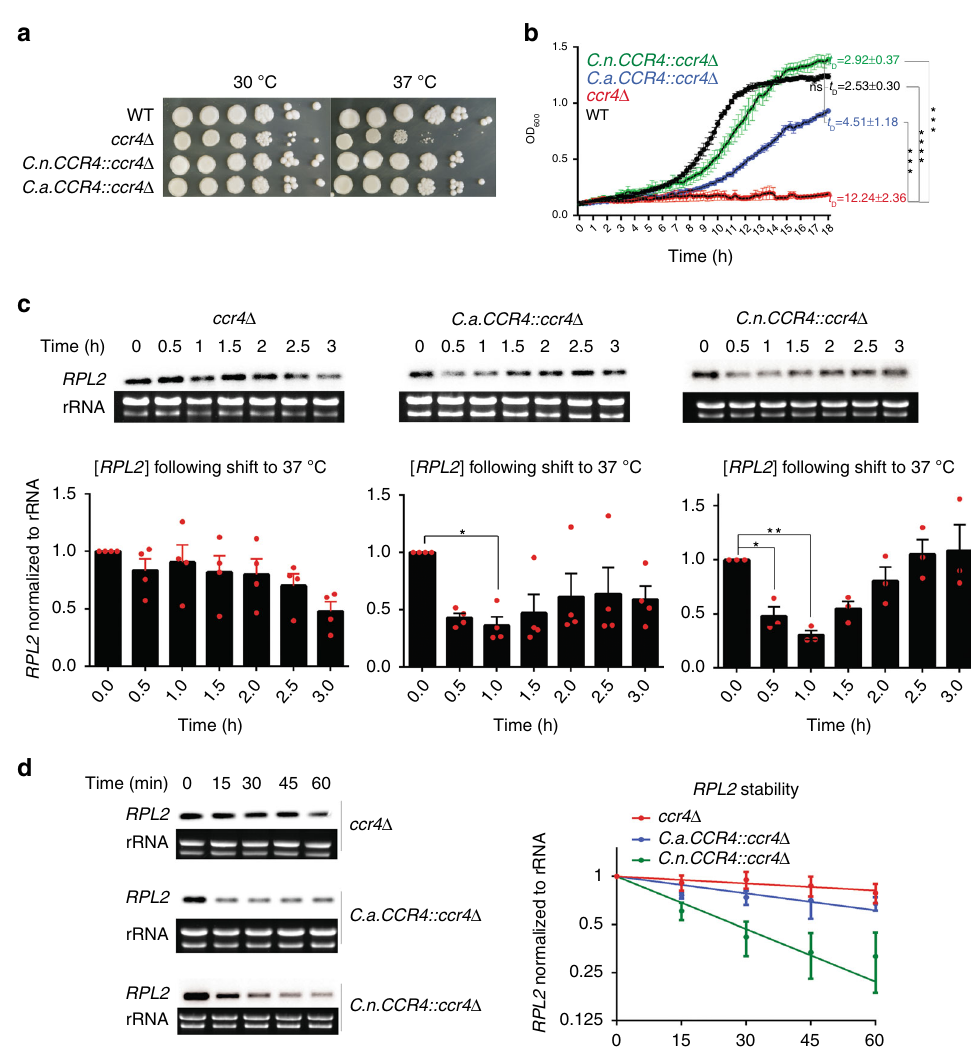
Fig. 2 C. amylolentus Ccr4 is functional and responds to 37 °C stress. a Cultures of wild-type C. neoformans , the C. neoformans ccr4 Δ mutant, the C. neoformans (C.n.) CCR4 :: ccr4 Δ , and the ccr4 Δ mutant strain expressing the C. amylolentus CCR4 ( C.a.CCR4::ccr4 Δ ) gene were adjusted to OD followed by tenfold serial dilution. In total, 5 µ l of each dilution was spotted onto YPD agar plates and incubated at either 30 °C or 37 °C for 3 days. Images are representative of three biological replicates. b Growth curve analysis. Strains were incubated at 37 °C with orbital shaking for 18 h. Plotted are OD 600 ± s.e.m. from 15 min increments; n = 3. Doubling times ( t D ) during exponential growth were compared by ANOVA and Tukey ’ s test post hoc, n = 3. c RPL2 expression following a shift to host temperature for 3 h was assessed by northern blot analyses. Graphs show mean RPL2 levels± s.e.m. normalized to rRNA, n ≥ 3. Expression of RPL2 at each time point was compared with t = 0 for each strain by ANOVA with Dunnett ’ s test post hoc. d RPL2 stability following a shift to 37 °C in the presence of the transcriptional inhibitor, 1,10-phenanthroline, was assessed by northern blot analyses. Graphs show the log2 regression of RPL2 normalized to rRNA, n = 3. Signi fi cance between curves was detected by sum-of-squares F test, with p < 0.05 determining signi fi cant difference between regression lines. Source data are provided as a Source Data fi